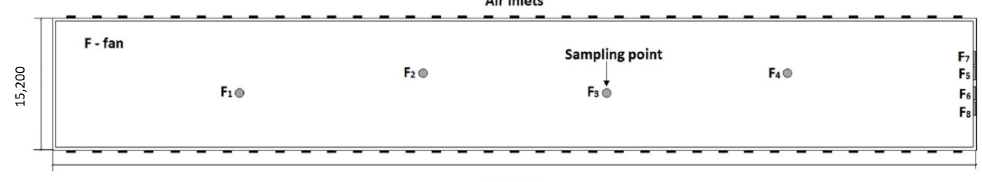
Figure 4. Sampling points in the poultry house.